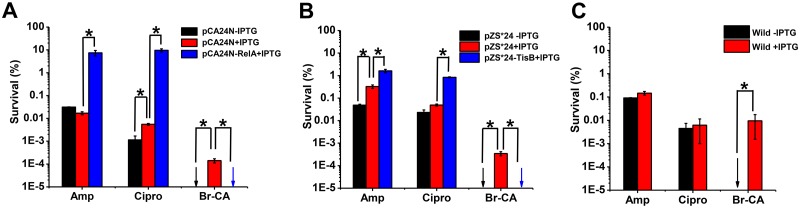
The persisters induced by toxin overexpression were eradicated by Br-CA.(A) The persisters were induced by RelA overexpression and the effects of IPTG on the persister formation in MG1655/pCA24N; (B) The persisters were induced by TisB overexpression and the effects of IPTG on the persister formation in MG1655/pZS*24; (C) The effects of IPTG on the persister formation in MG1655. Cell survival percentage after treatment was calculated based on the colony counts on the LB agar plates. The arrows indicated that persister cells were eradicated completely and different colors showed different treatments. Each data point or bar was indicated as the means of three replicates ± standard deviation. Asterisks indicate a significant difference from their controls (P <0.05).